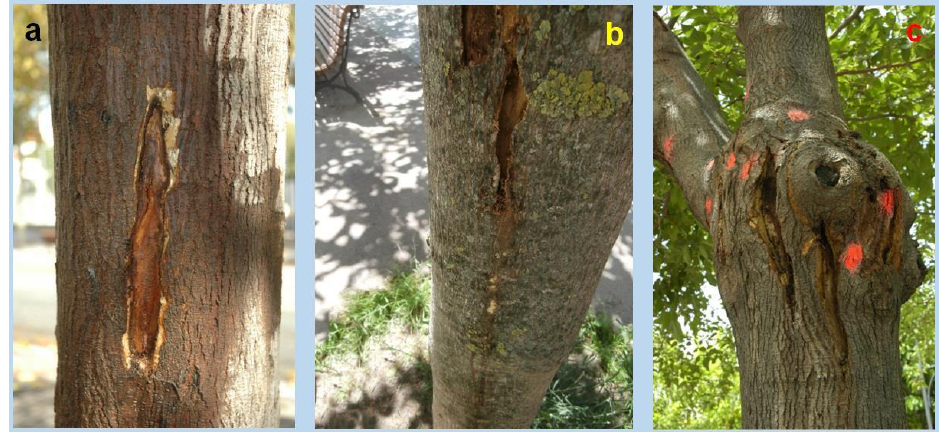
Figure 5. Exposed larval feeding cavities of X. chinensis in mulberry phloem: ( a , b ) along trunks; ( c ) at the base of main tree branches, red/orange dots point out adult emergence holes (( a , c ): photos V. Sarto i Monteys; ( b ): photo G. Torras).